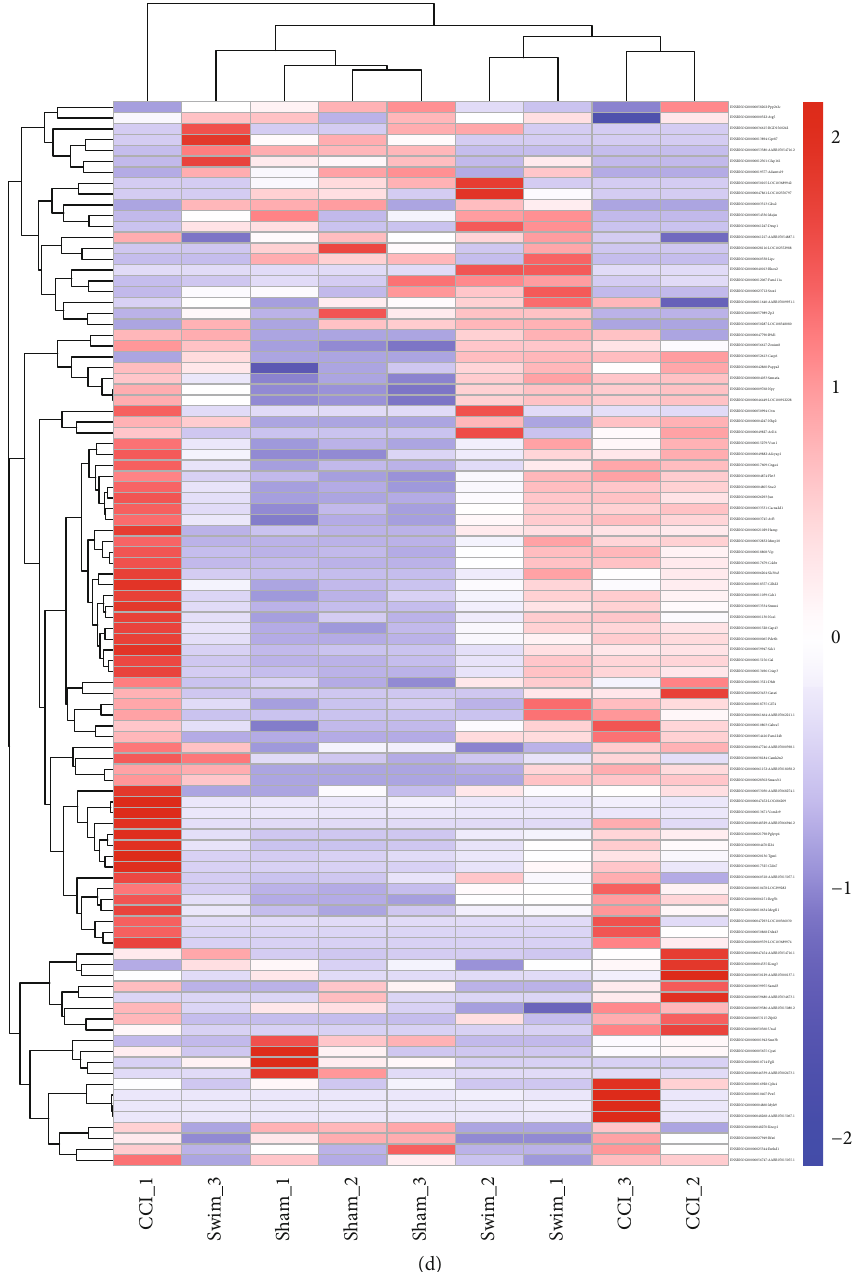
Figure 6: Expression pro fi le changes in mRNA in the dorsal root ganglion (DRG). (a) Volcano plot indicating upregulated and downregulated di ff erentially expressed mRNAs between the chronic constrictive injury (CCI) and sham-operated groups. (b) Volcano plot indicating upregulated and downregulated di ff erentially expressed mRNAs between the CCI and CCI-exercised groups. Magenta dots represent genes with signi fi cantly upregulated expression, blue dots represent genes with signi fi cantly downregulated expression, and grey dots represent genes with no signi fi cant di ff erence. (c) Overlap of di ff erentially expressed mRNAs between the two comparisons shown as a Venn diagram. (d) Heatmap showing the relative expression levels of di ff erentially expressed mRNAs among the three groups. Upregulated and downregulated genes are colored red and blue, respectively ( n = 3 animals per